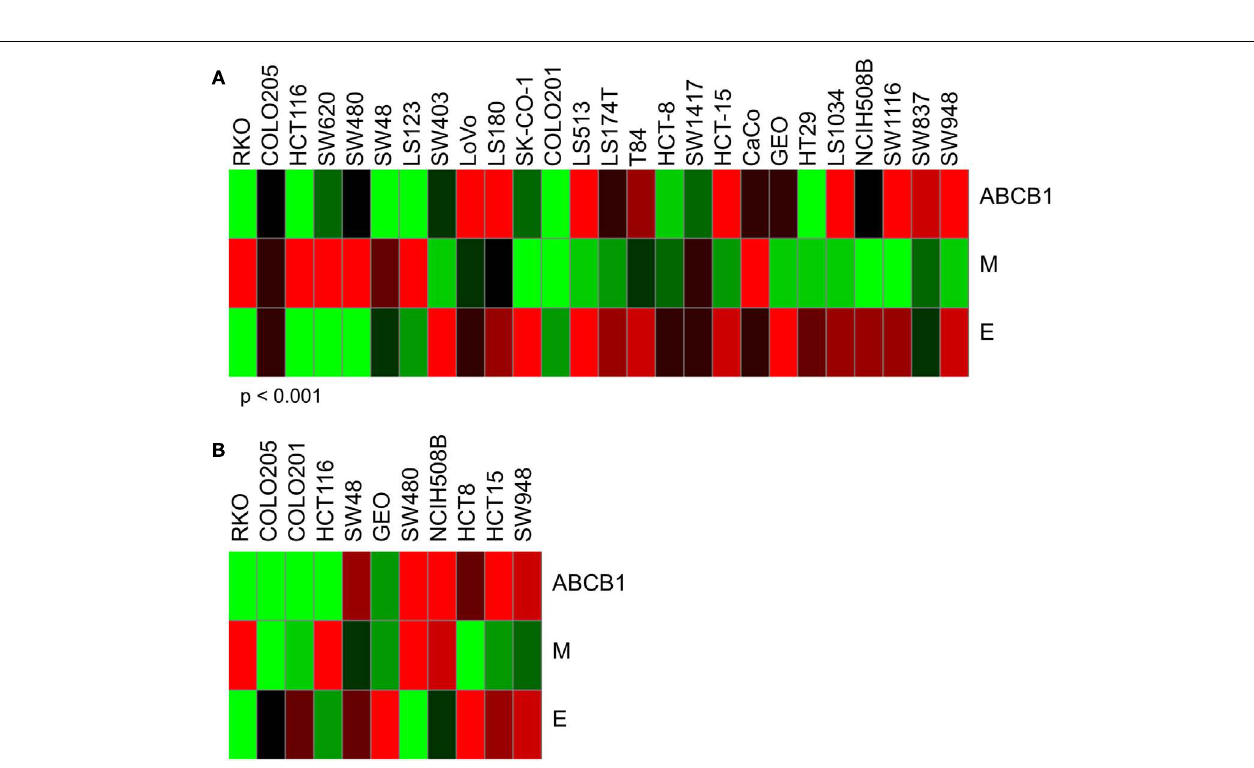
FIGURE 7 | Decreased tumor concentration of PF-309 corresponds with tumor P-gp expression in vivo . (A) Tumor concentrations of PF-309 were measured 6h post treatment of a single 25mg/kg dose. Higher concentrations of PF-309 were measured in HCT116 and GEO tumors than SW480 and HCT15 tumors. (B) Western blots were